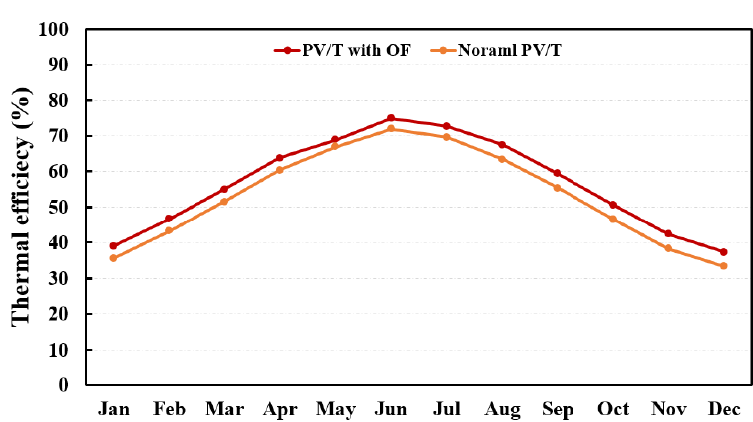
Figure 8. Thermal efficiency.